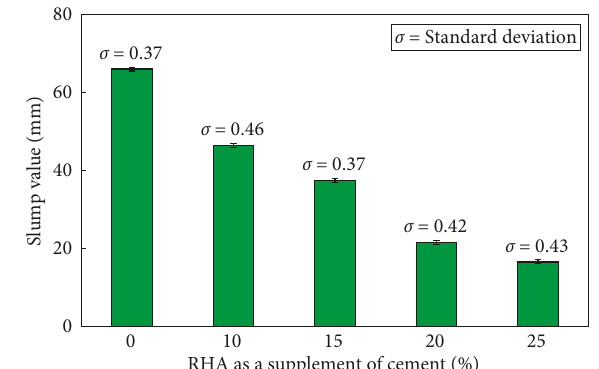
Figure 3: Slump of BAC containing RHA as a supplement of